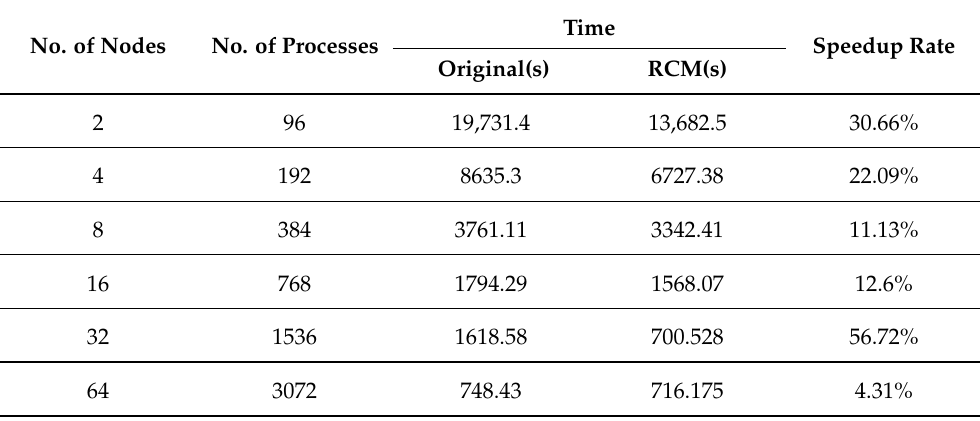
Table 5. The degree of enhancement of the RCM algorithm for numerical simulation of fuel rod bundles at different parallel scales. The first column represents the number of nodes. The second column represents the amount of processes. The third and fourth columns indicate the total simulation time for the original grid and the grid renumbered by RCM. The fifth column indicates the numerical simulation speedup of the renumbered grid compared to the original grid. Time No. of Nodes No. of Processes Speedup Rate